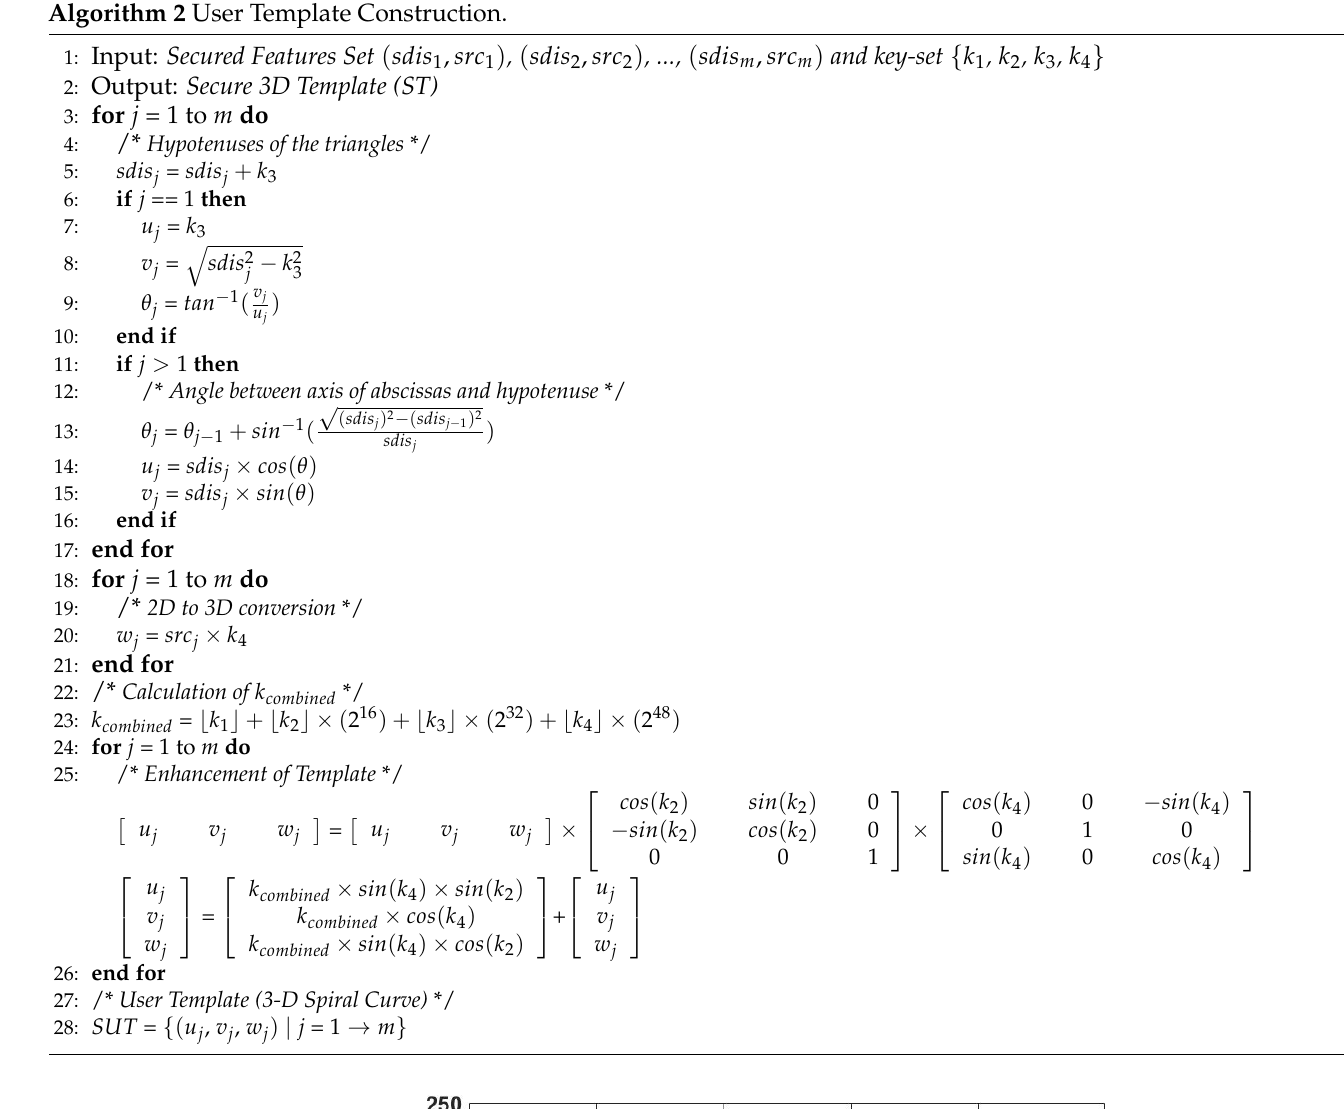
Algorithm 2 User Template Construction.